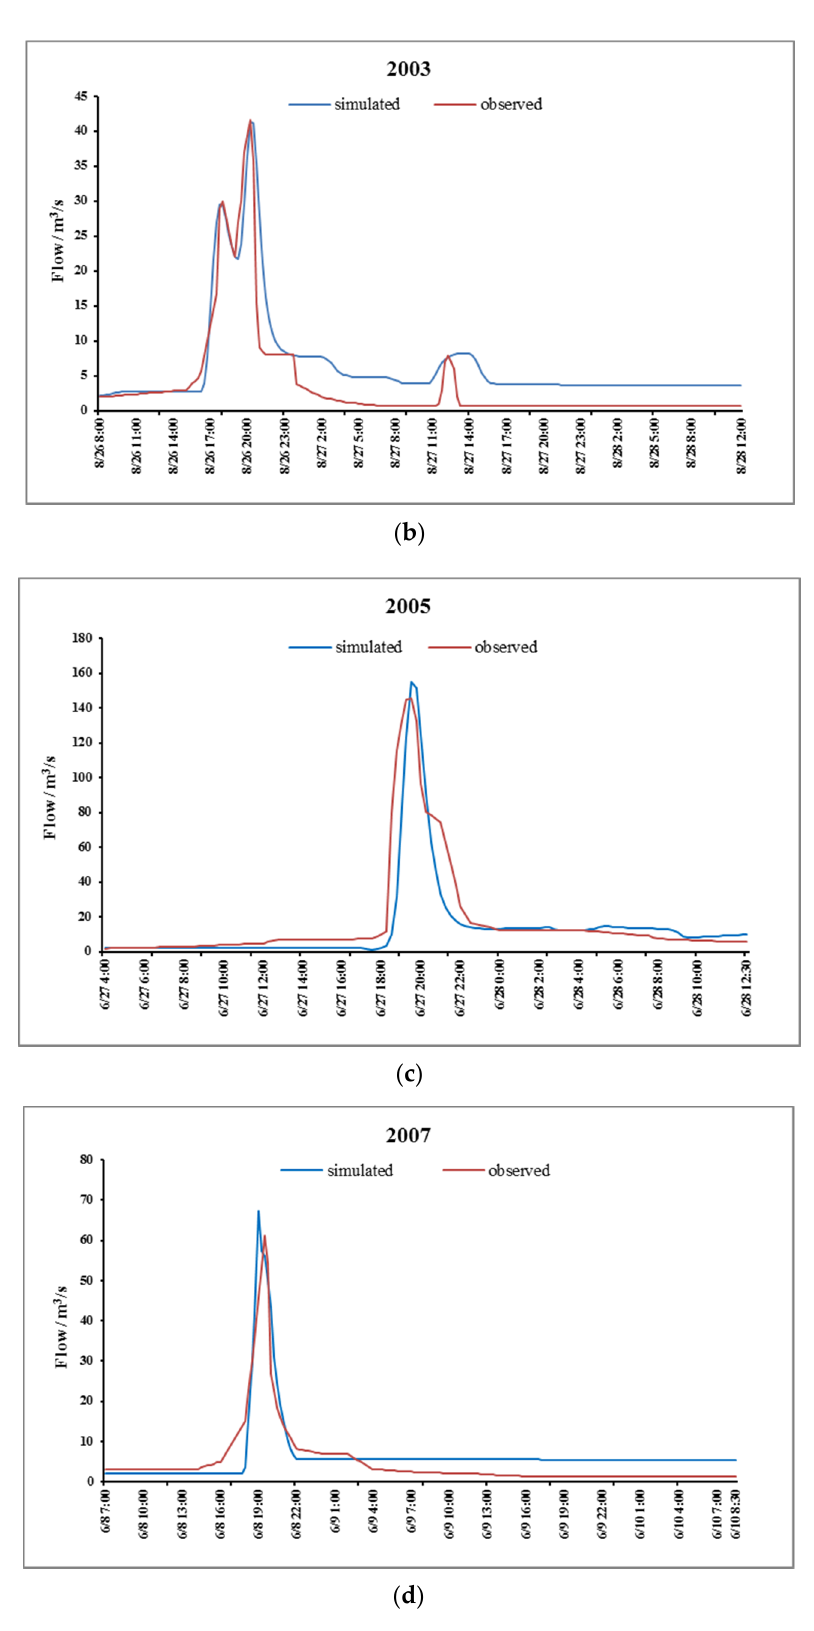
Figure 10. Observed and simulated hydrographs of the 2000s.